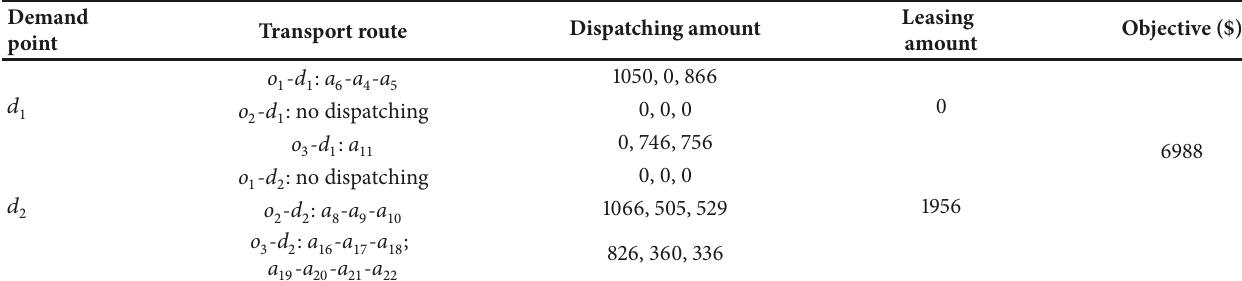
Table 4: Dispatching scheme 2.